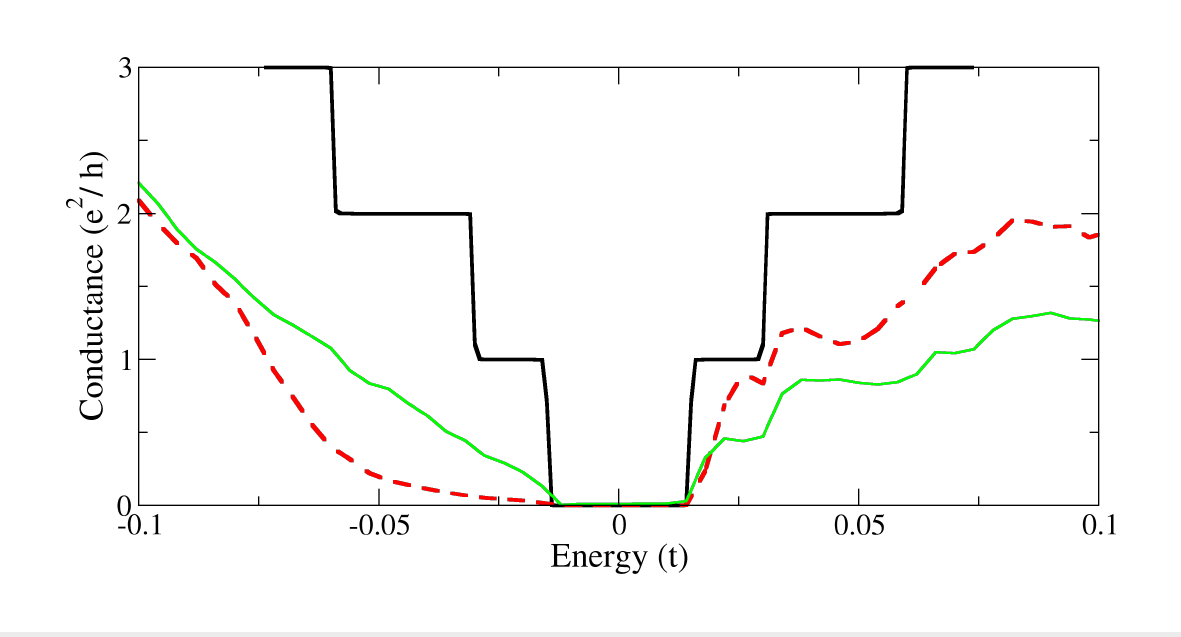
Figure 4: Quantum conductance through a 15 nm wide graphene nanoribbon with a 7.5 nm long scattering region containing a dispersion of substitu- tional nitrogen impurities, in a similar vein to the method of Botello-Mendez et al. [37], calculated using a recursive Green’s Function method [55,56], the Kubo formula for conductance [57] and a configurational average of 50 systems. Energy is in units of the tight binding nearest neighbour hopping energy between carbon atoms, t = 2.7 eV. Shown is the predicted conductance for pristine (black), randomly doped (green solid) and single sublat- tice doped (red dashed) systems, where a dopant concentration of 1% nitrogen was